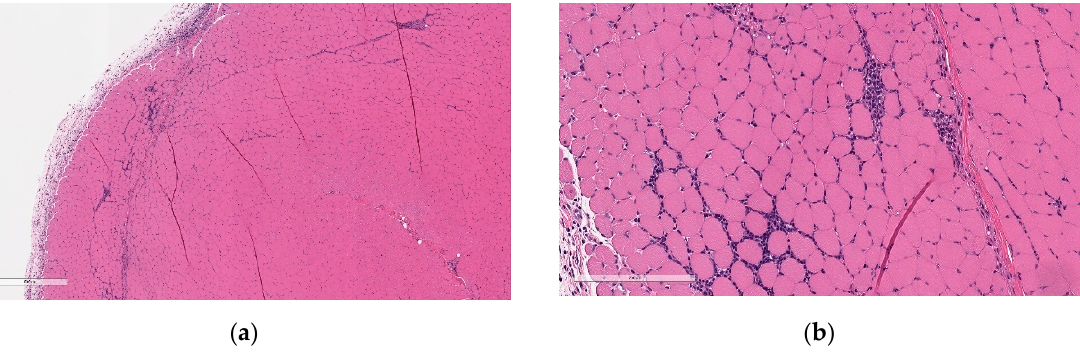
Figure 6. Histopathologic features of Injection site inflammation at the end of recovery. ( a ) Injection site sections of BNT162b2 (V9) treated animals euthanized after 3-week recovery showed fewer inflam- matory cells infiltrating and expanding subcutaneous tissue and spaces around skeletal myofibers. ( b ) Higher magnification of ( a ) showing inflammatory cells (fewer plasma cells and lymphocytes) surrounding myofibers. Data are scanned from Study 2.